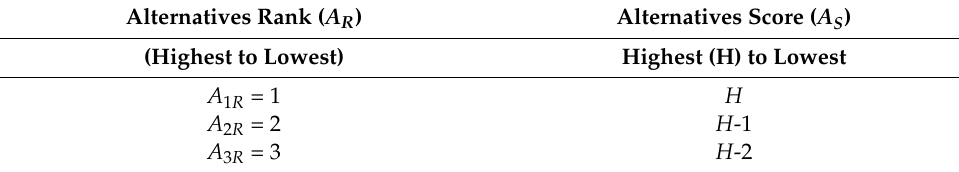
Table 2. Rank and score provision for the unanimous decision-making score (UDS) [42].